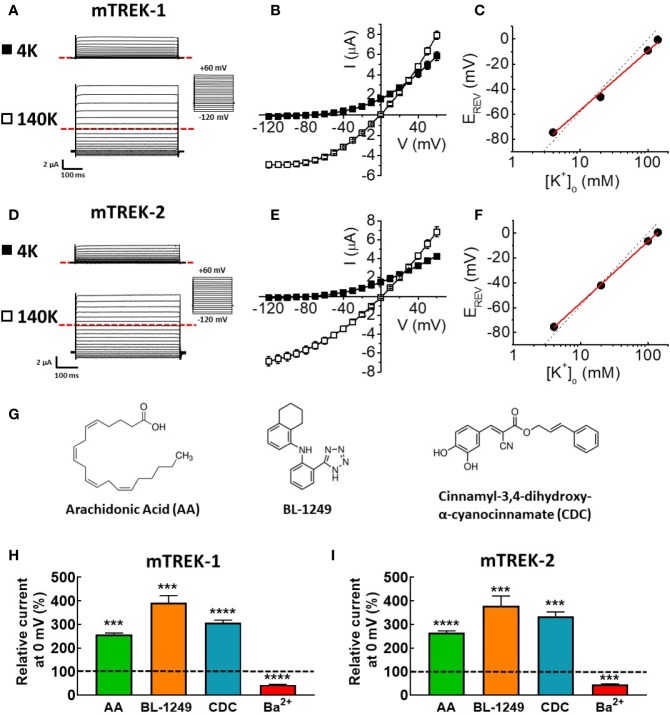
Mouse TREK-1 and TREK-2 channels are biophysically and pharmacologically comparable to their human counterparts. Exemplar current traces of mTREK-1 (A) and mTREK-2 (D) elicited by voltage pulses from −120 to +60 mV in 10 mV steps, for 500 ms from a holding potential of −80 mV (inset), in both asymmetric K+ solutions (4 mM) or symmetric K+ solutions (140 mM). In each panel, scale bars represent 2 μA and 100 ms. The zero current level is indicated by red dashed line. (B, E) Mean current-voltage (I-V) relationships taken from steady-state currents in bath solution containing low (asymmetric) K+ (4 mM, black squares) or high (symmetric) K+ (140 mM, open squares) for (B) mTREK-1 (n = 7) and (E) mTREK-2 (n = 8). (C, F) Reversal potential (EREV) plotted as a function of [K+]o (mean ± SEM) for (C) mTREK-1 and (F) mTREK-2 currents. Data points are fitted with a linear relationship (red line). Dashed line represents Nernstian theoretical linear relationship of equilibrium potential for K+ (EK) with changing [K+]o as calculated using the Nernst equation, assuming [K+]i of 140 mM (slope = −58.2 mV). (G) Chemical structures of three main activators of TREK channels. (H, I) Bar graphs showing effects on mean (± SEM) normalized mTREK-1 (H) and mTREK-2 (I) currents measured at 0 mV (in %) after application of either 10 μM AA, 1 μM BL-1249 (mTREK-1), 3 μM BL-1249 (mTREK-2), 10 μM CDC, or 1 mM Ba2+. Dashed line indicates control current level. All data represents n > 6 oocytes. ***p < 0.001, ****p < 0.0001, Student's paired t-test conducted on raw data.